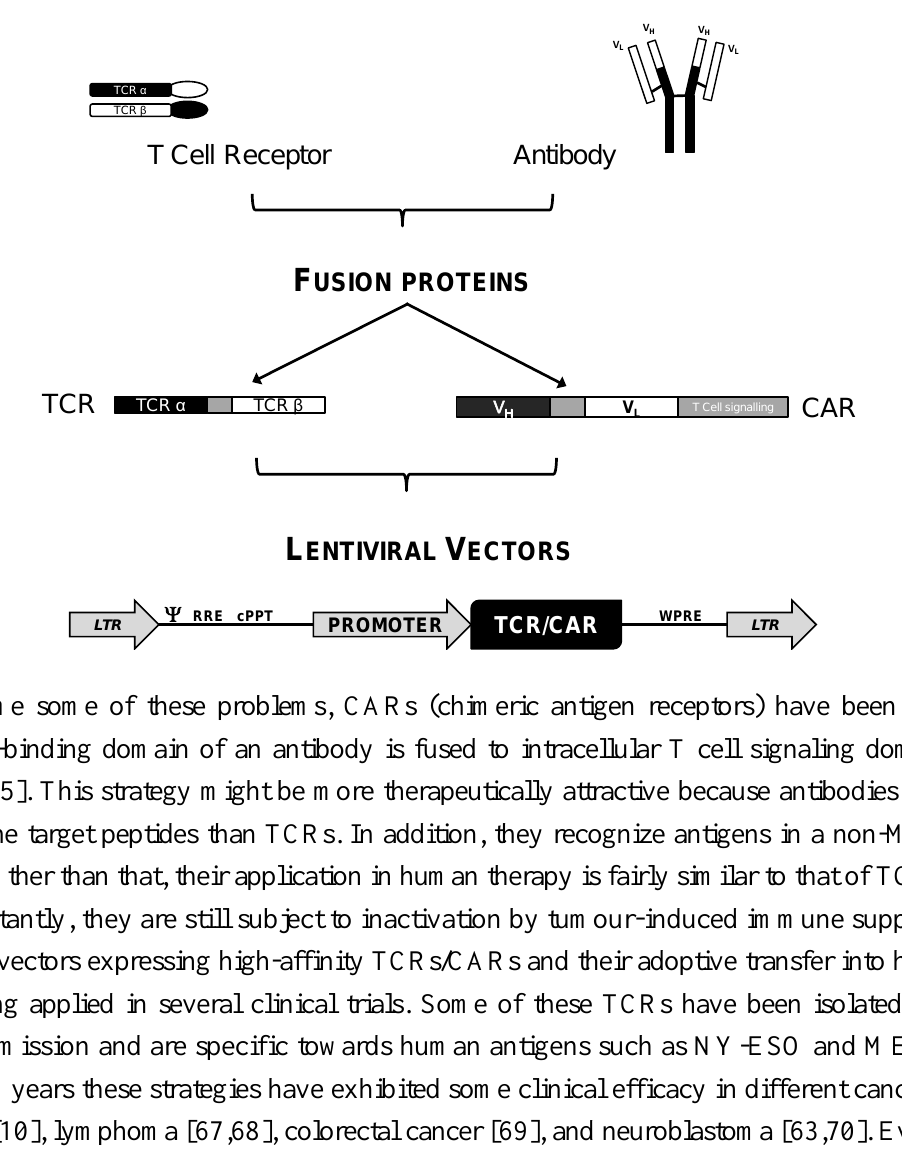
Figure 4. Introduction of TAA-specific TCRs or CARs to autologous T cells for cancer immunotherapy. Tumour-reactive T cells are isolated from patients that underwent tumour remission after ―conventional‖ immunotherapy. The genes encoding both TCR chains are amplified by PCR and cloned into retrovirus/lentivirus vectors (top left of the figure). CARs are produced by engineering a fusion gene between the antigen-binding region of an antibody with selected intracellular T cell signalling domains (top right of the figure). Lentivectors are depicted here as an example of TCR/CAR gene carriers. VH and VL, immunoglobulin variable regions; LTR, long terminal repeat;  , packaging signal; RRE, rev responsive element; cPPT, central polypurine flap; WPRE, woodchuck post-transcriptional